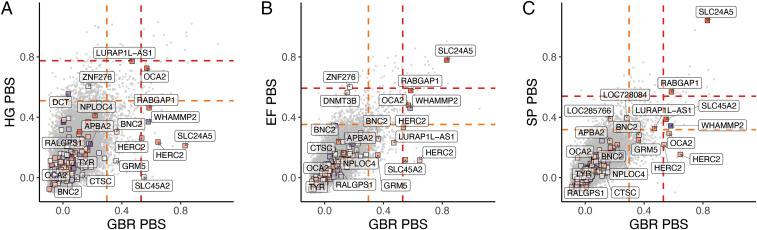
Joint PBS distributions for 20-SNP windows across the genome for GBR-CHB-YRI on the x axis and X-CHB-YRI on the y axis, with X being (A) hunter-gatherer, (B) Early Farmer, and (C) Steppe. The boxes represent windows centered around UK Biobank skin pigmentation SNPs and are colored redder according to how much higher the light allele frequency is in X compared to YRI. Nearest genes are labeled. The orange and red lines represent the top 1 and 0.1 percentiles.